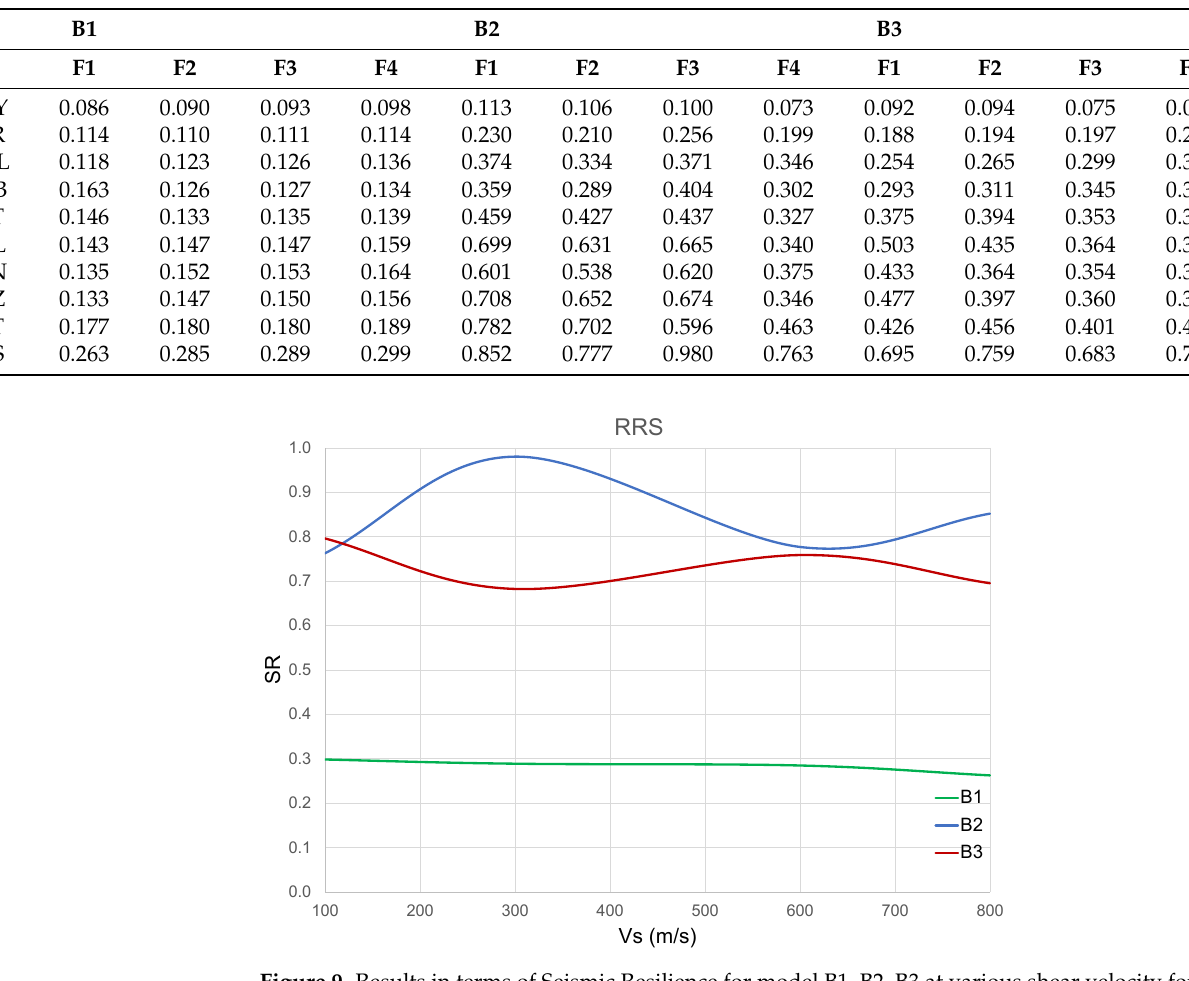
Figure 9. Results in terms of Seismic Resilience for model B1, B2, B3 at various shear velocity for RRS motion (see last line of Table 9). Table 9. Seismic Resilience (SR): the last line (RRS) has been reproduced in Figure 9.